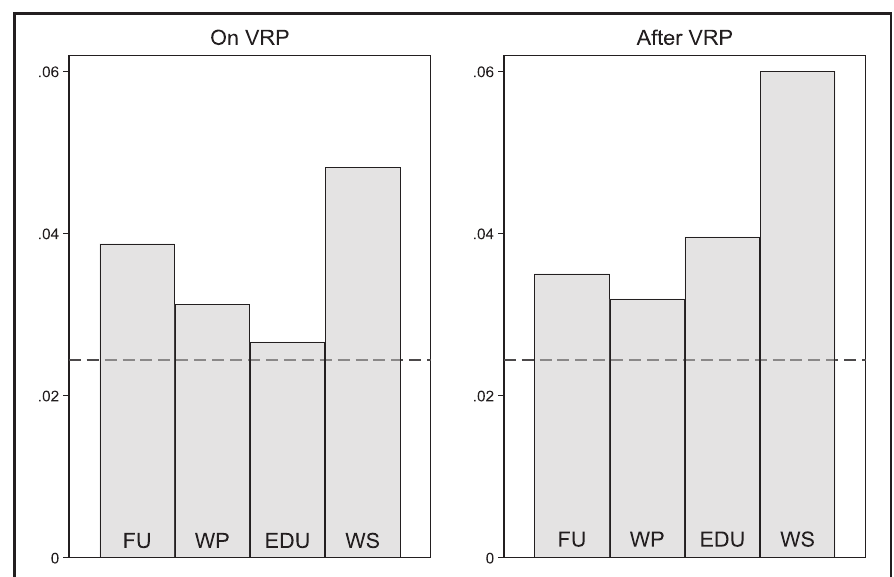
Figure 6 The effect of the vocational rehabilitation program (VRP) on the transition to job/ education. FU, follow-up; WP, work practice; EDU, education/training; WS, Wages Subsidies.